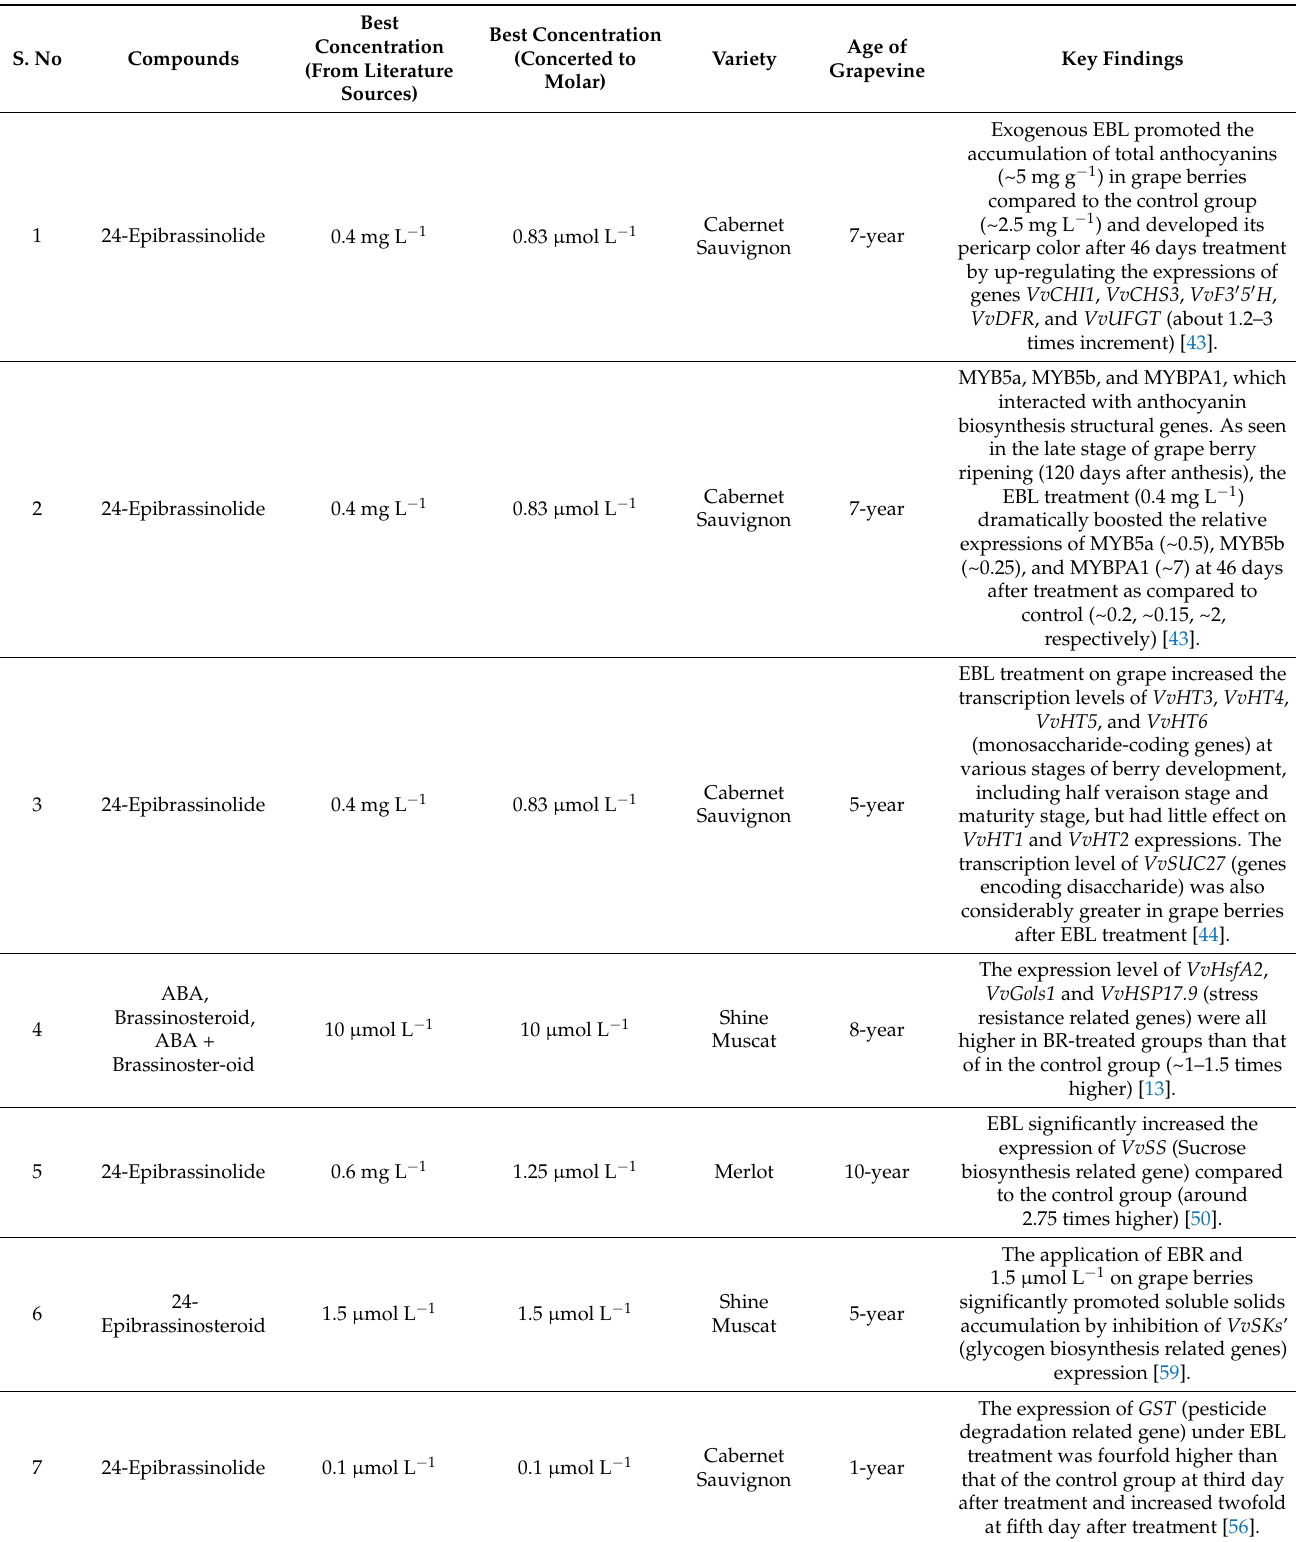
Table 4. Role of exogenous brassinosteroid/brassinolide to enhance the fruit quality parameter regarding molecular